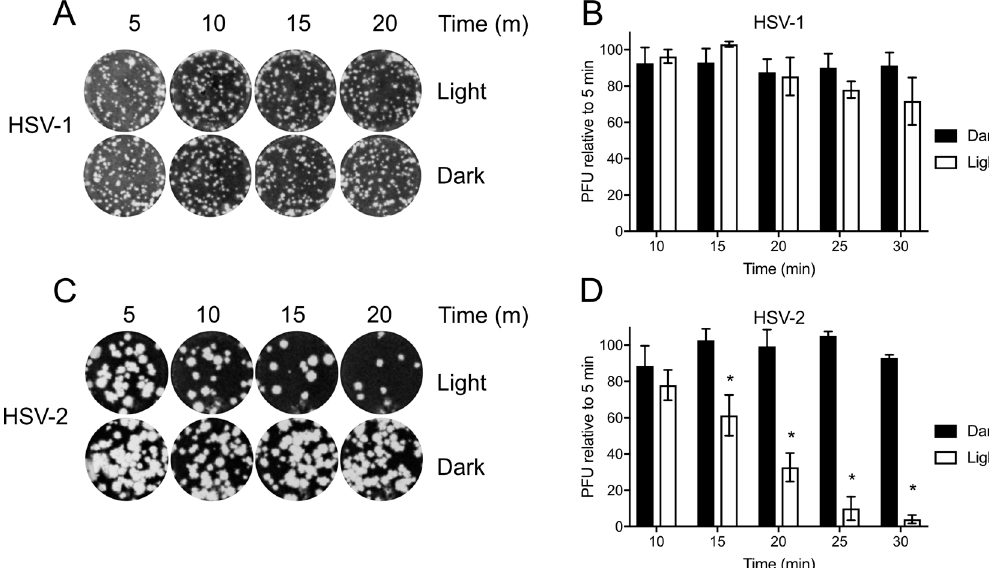
Figure 3. Differential sensitivity of HSV-1 and HSV-2 to white light. Viral inoculum was diluted and exposed to a 65 W LED light in clear (light) or black (dark) tubes for the indicated times, and used to infect HeLa cell monolayers as described in the methods. ( A ) Representative image of HSV-1 plaque assay, quantified in ( B ). ( C ) Representative HSV-2 plaque assay, quantified in ( D ). Values in ( B , D ) are normalized the number of PFUs detected after 5 min of light exposure. n = 3 ± SEM from three independent biological replicates. * = p < 0.05 by two-way ANOVA.